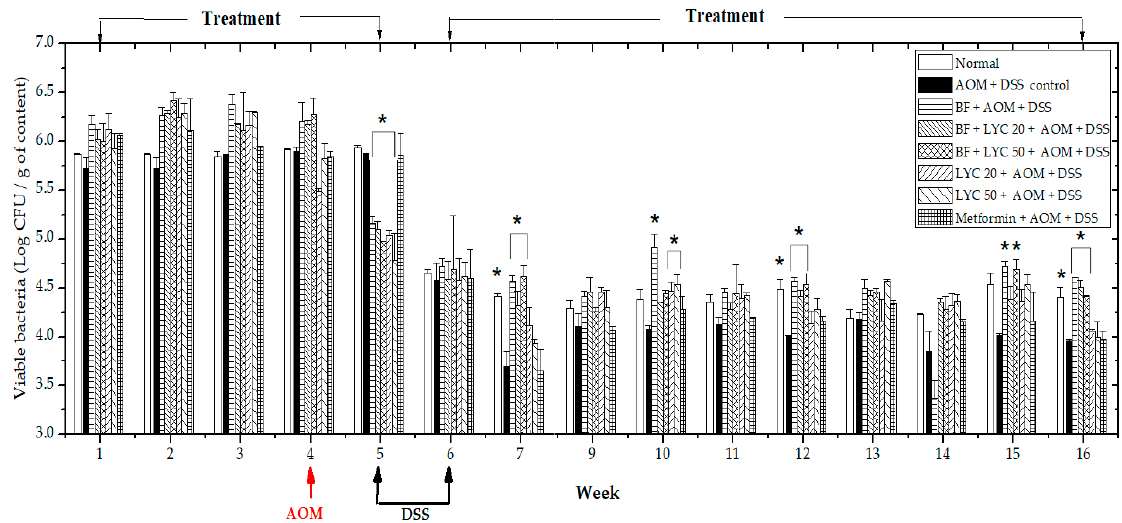
Figure 1. Bifidobacterium longum viability in feces of CD-1 mice during the 16 weeks. Values are Log CFU/g of feces. The asterisks (*) indicate significant differences compared to the AOM + DSS control group (Dunnett α = 0.050). Each bar represents the mean ± SEM ( n = 6–10 animals per group).